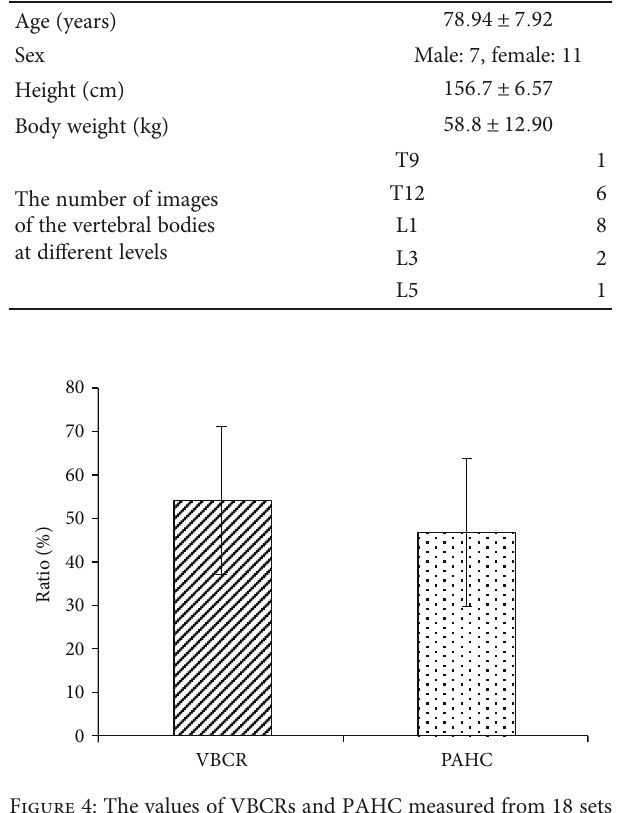
Table 1: Patient characteristics.